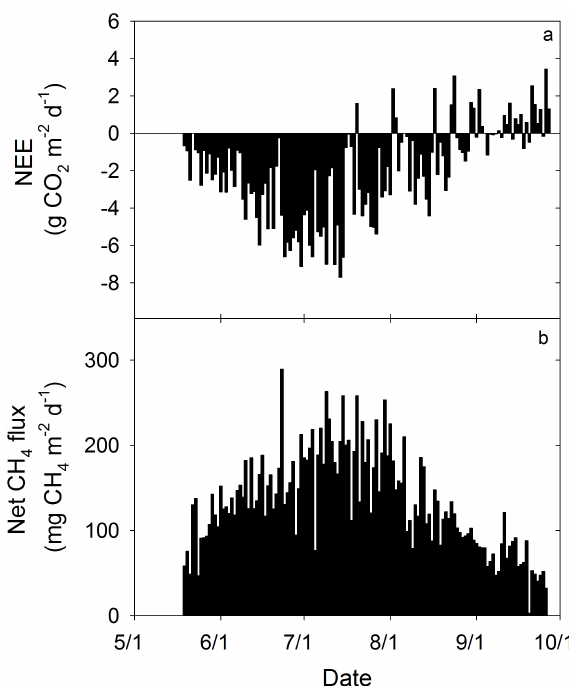
Fig. 3. Mean diurnal net ecosystem CO 2 exchange (NEE) (a) and net CH 4 (b) fluxes for poor fen from 19 May to 27 September 2011. Error bars represent the standard error. Positive values represent fluxes to the atmosphere and negative values represent losses from the